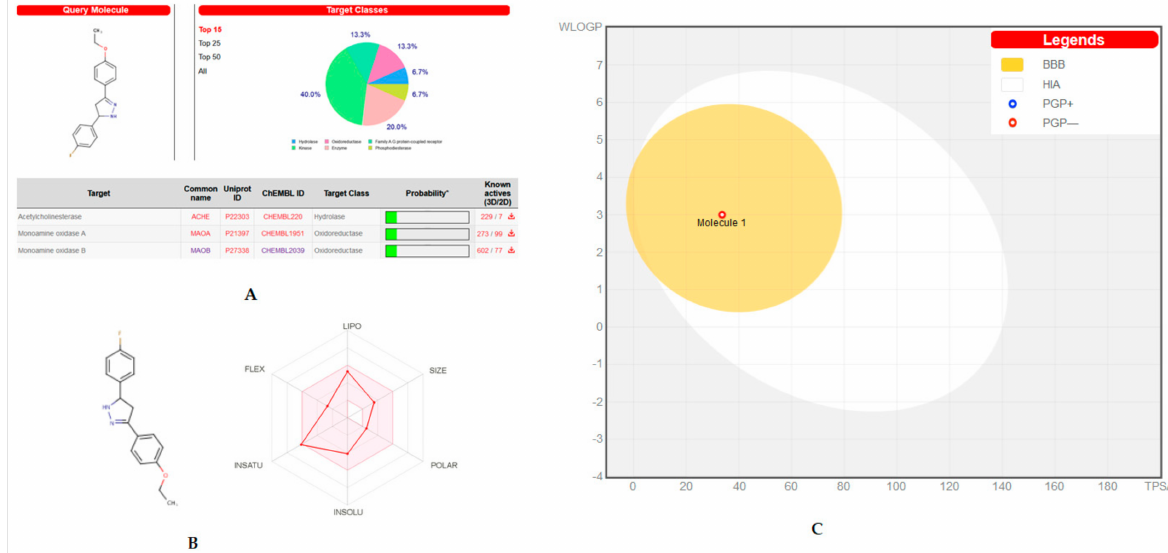
Figure 11. Swiss target/ADME prediction: ( A ) Biological target prediction of lead molecule EH7 ; ( B ) bioavailability radar of EH7 ; ( C ) the BOILED-Egg construction of EH7